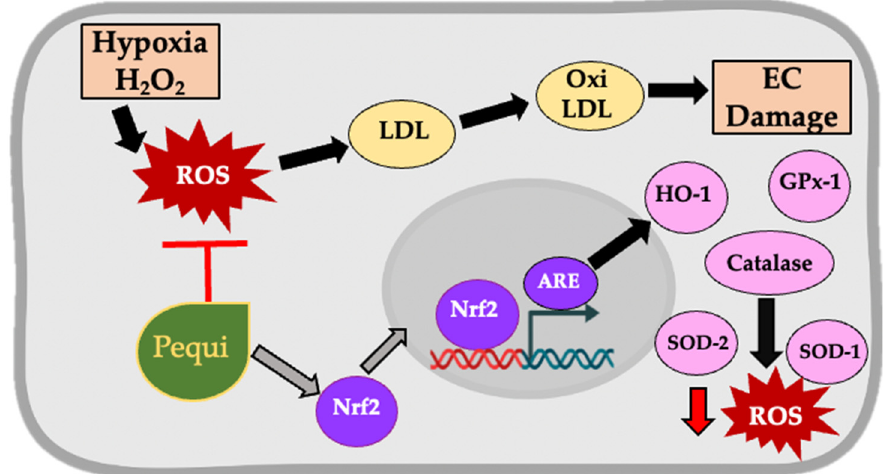
Figure 7. Proposed mechanisms of reduction in ROS in human coronary endothelial cells (HCAEC) by pequi extract. Hypoxia and H 2 O 2 increase cytosolic and mitochondrial ROS in HCAEC. Polyphenol-rich pequi extract induces expression of antioxidant enzymes as a first line of defense against ROS, possibly by activating the Nrf2/ARE pathway and may reduce ROS and induce HCAEC proliferation. LDL: Low-density Lipoprotein; EC: Endothelial Cells; ARE: Antioxidant Responsive Element; Nrf-2: Nuclear factor-erythroid factor 2-related factor 2; HO-1: Heme Oxygenase-1; SOD-1: superoxide dismutase-1; SOD-2: superoxide dismutase-2; ROS: Reactive Oxygen Species.